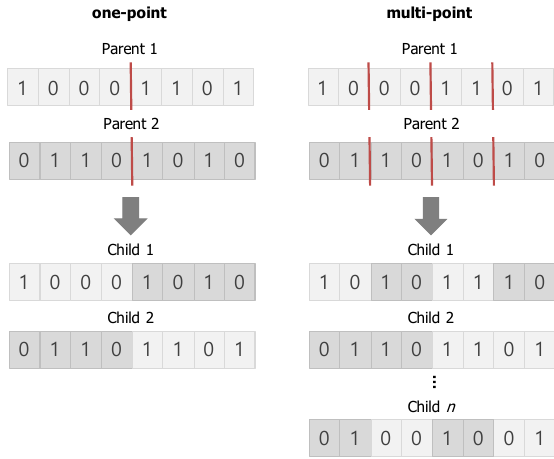
Figure 4. k -point crossover: blockwise reproduction.